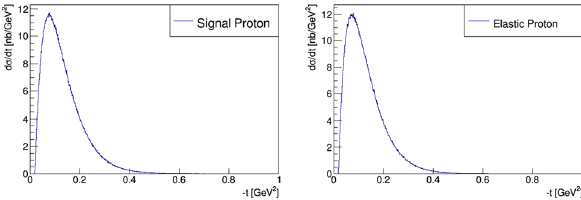
Fig. 4 The t distribution of the radiating